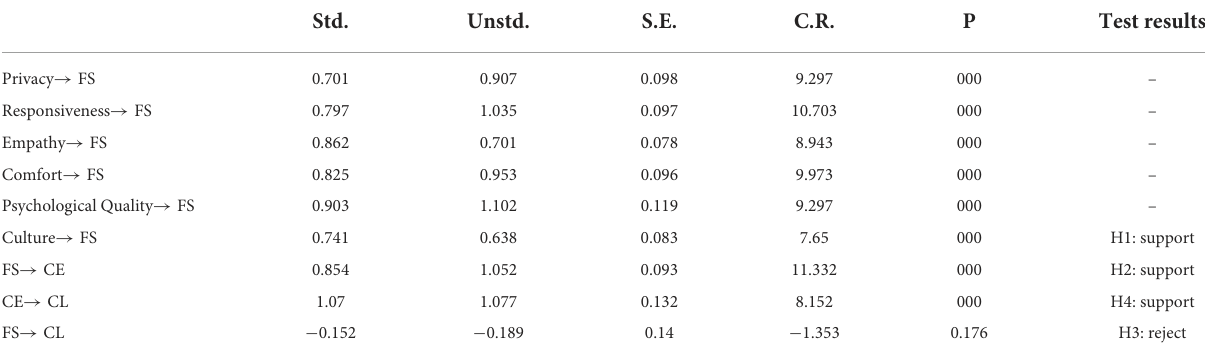
TABLE 8 Results of path verification.